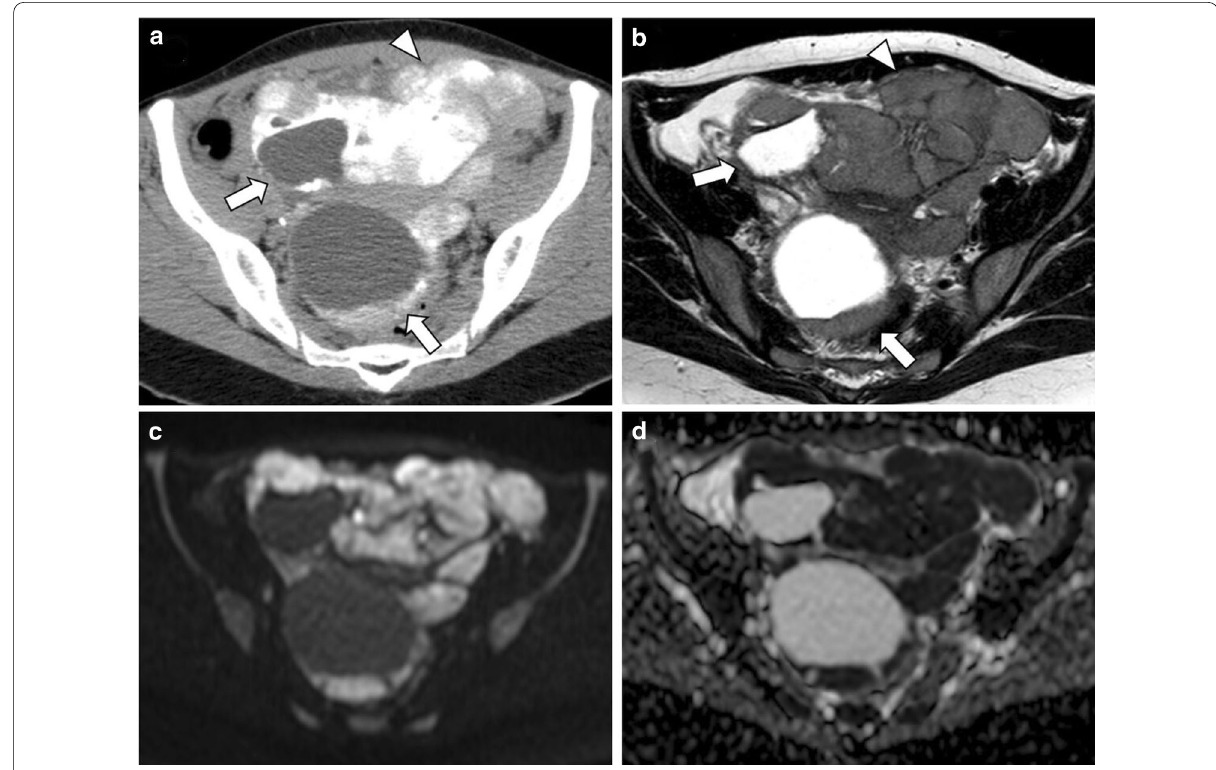
Fig. 4 Bilateral ovary LGSC with multiple peritoneal metastases in a 22-year-old female. Axial unenhanced CT image ( a ) and axial T2-weighted MR image ( b ) demonstrate a complex bilateral mixed ovarian tumour, with solid parietal components (arrows) and multiple pelvic solid metastases with exuberant calcified psammoma bodies (arrowheads). Axial b -1000 s/mm 2 diffusion-weighted image ( c ) and ADC map ( d ) show diffusion restriction in parietal nodules and peritoneal metastases